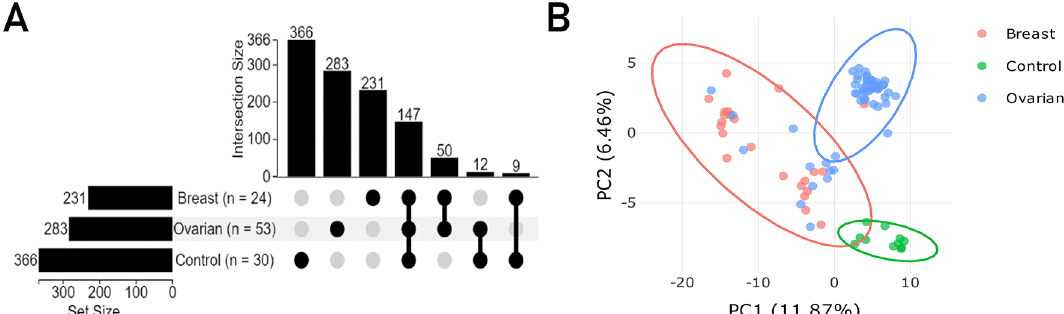
Figure 1. The upset diagram showing the distribution and the intercept size of protein identifications amongst groups of breast and ovarian cancer phenotypes, and the control group ( A ). PCA analysis carried out for the mutual fraction of proteins ( n = 147) with no imputation and reflecting the quantitative alteration of the identified proteins between groups: breast cancer (BC)—red ellipse, ovarian cancer (OC)—blue ellipse and the control (CNT)—green ellipse. The abundancy (quantitative item) was fit to the log-scale ( B